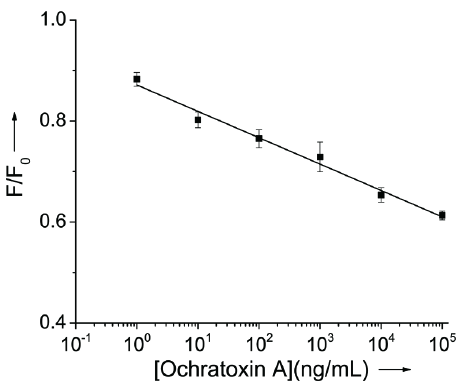
Figure 5. Calibration plot relative F/F 0 of the PG/aptamer duplex mixture against different concentrations of OTA in 1% beer. F 0 and F stand for the fluorescent intensity in the absence and presence of